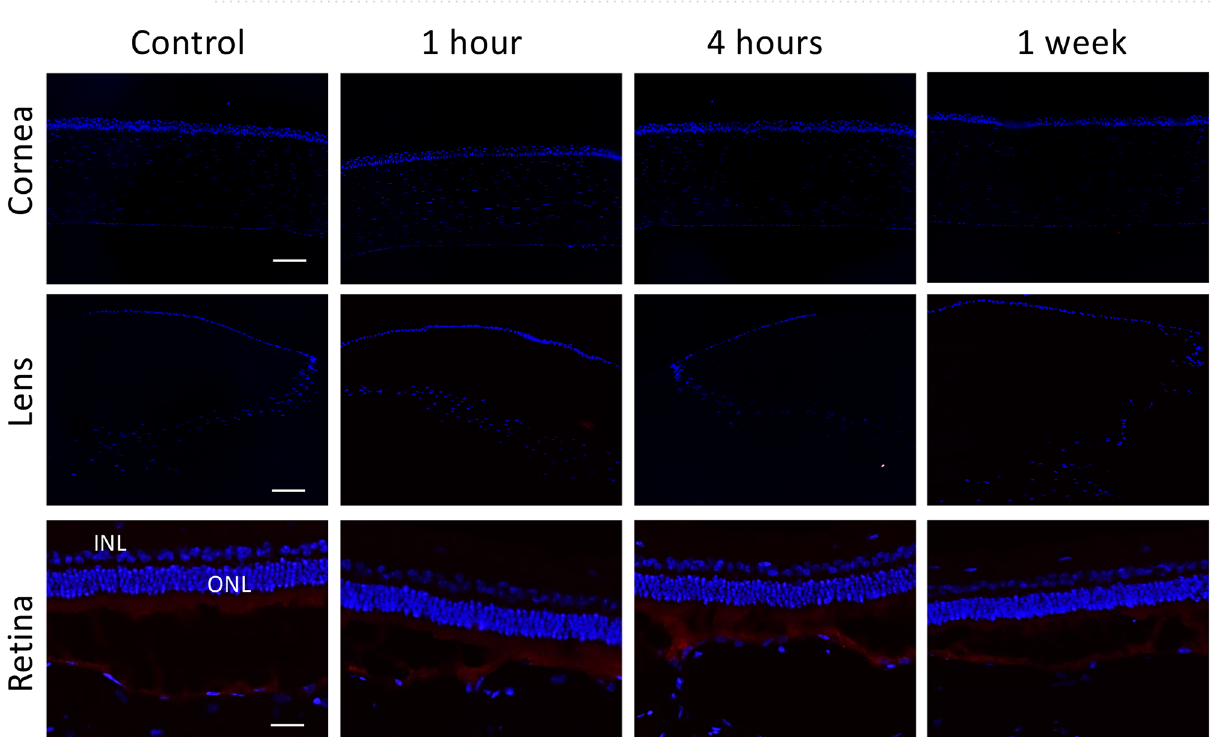
Figure 9. There were no TUNEL-positive staining cells at all time points, in corneas, lens epithelium and retinal layers. IPL: inner plexiform layer; ONL: outer nuclear layer. Nuclei were counterstained with DAPI (blue). Scale bar 100